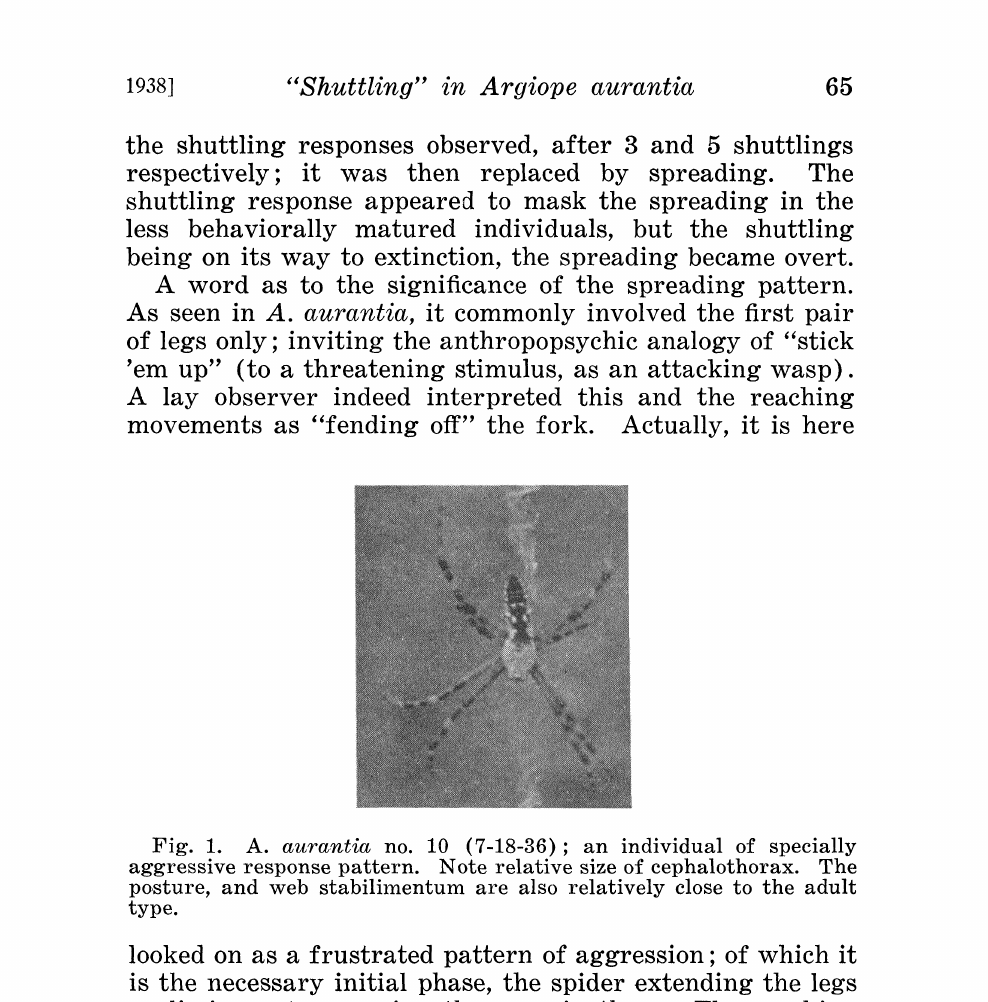
Fig. 1. A. aurantia no. 10 (7-18-36); an individual oi specially aggressive response pattern. Note relative size of cephalothorax. The po.sture, and web stabilimentum are also relatively close to the adult